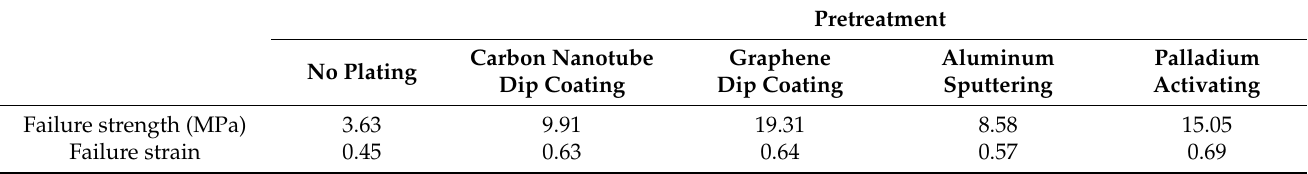
Figure 12. Compressive load-displacement relations to failure of the 130- μm micro -lattice struc- tures with different plating treatments. Table 6. Compressive failure load and displacement of the micro-lattice structures with unit cell length of 130 μm with different nickel -plating treatments.